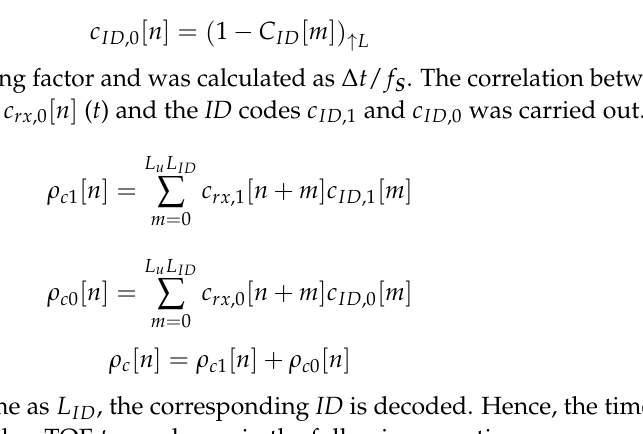
Figure 6. Ultrasonic transmission/reception test environment: ( a ) ultrasonic transducer, ( b ) experi- ment environment. Table 1. Experimental parameters. Symbol Parameter